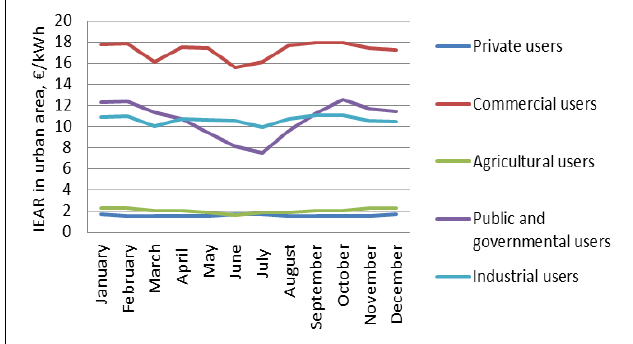
Fig. 5. IEAR in a rural area.